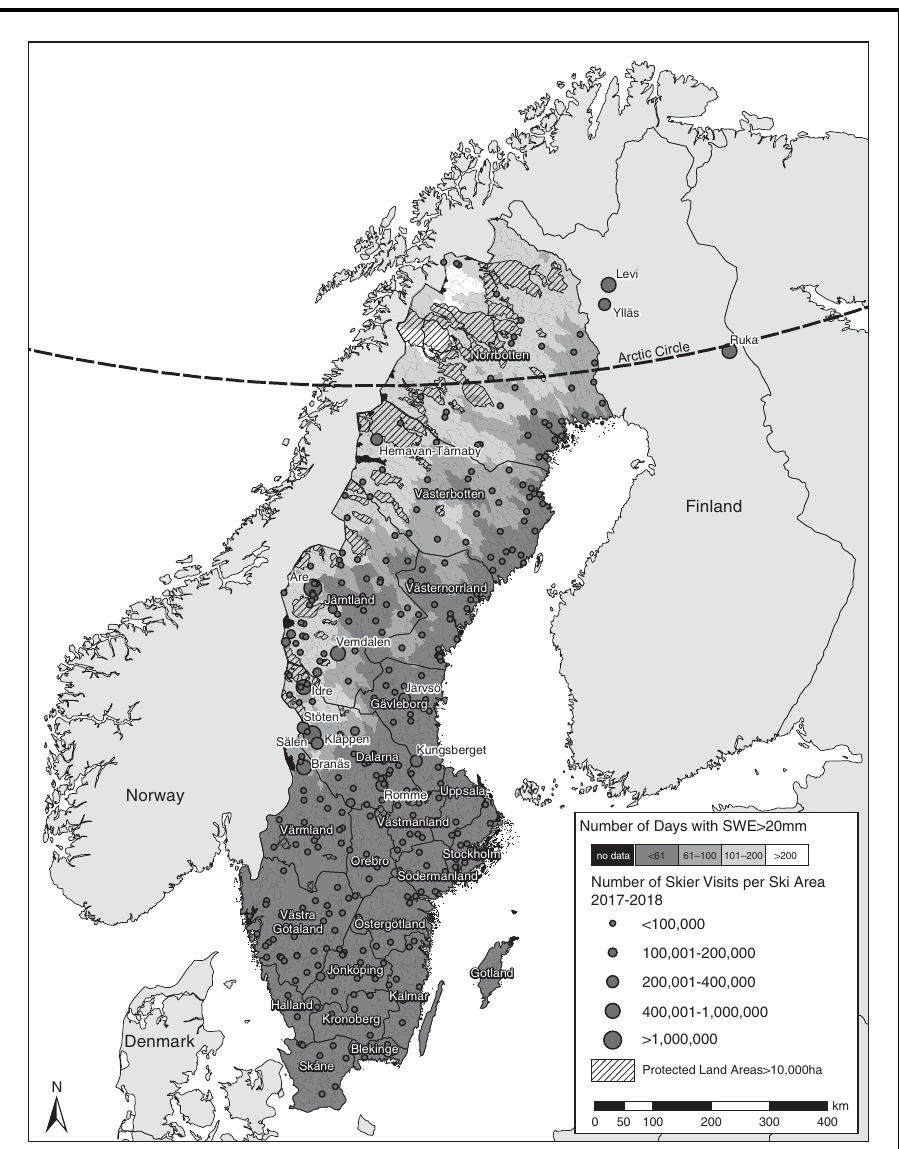
Figure 3 Snow reliability of downhill skiing areas in Sweden 2069 – 2098